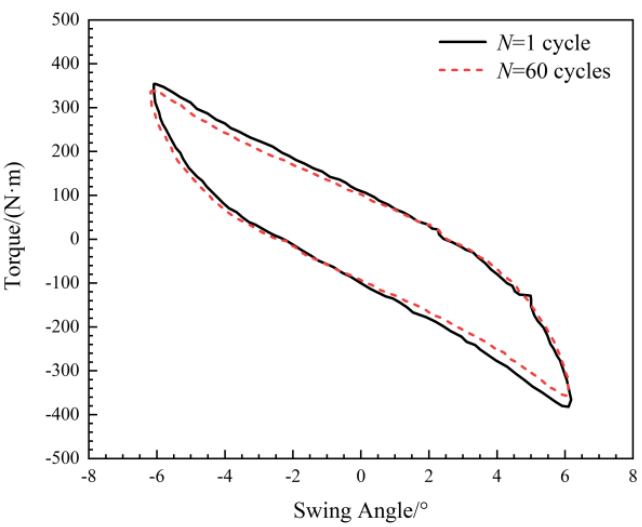
Figure 9. The hysteresis loops of flexible joint at N = 1 cycle and 60 cycles in swing fatigue test.